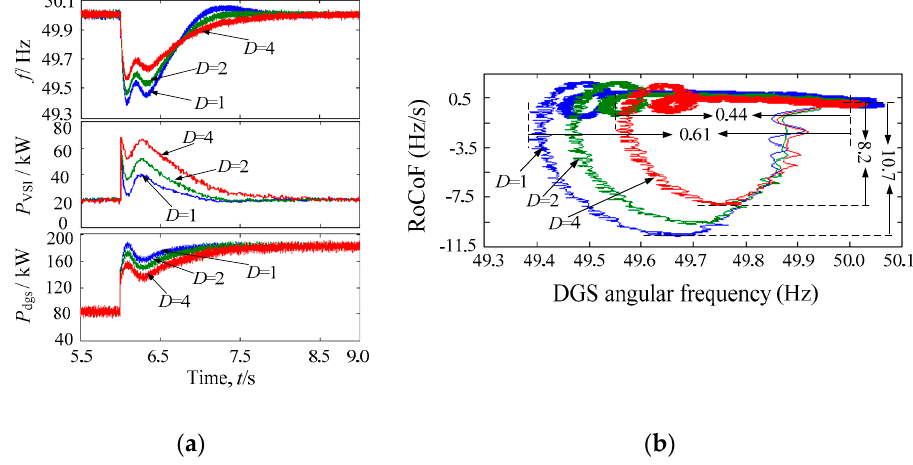
Figure 18. ( a ) Experimental results of the different values of virtual damping and zero virtual inertia on a power transient; ( b ) Angular frequency-acceleration curves of DGS with virtual damping control loop.